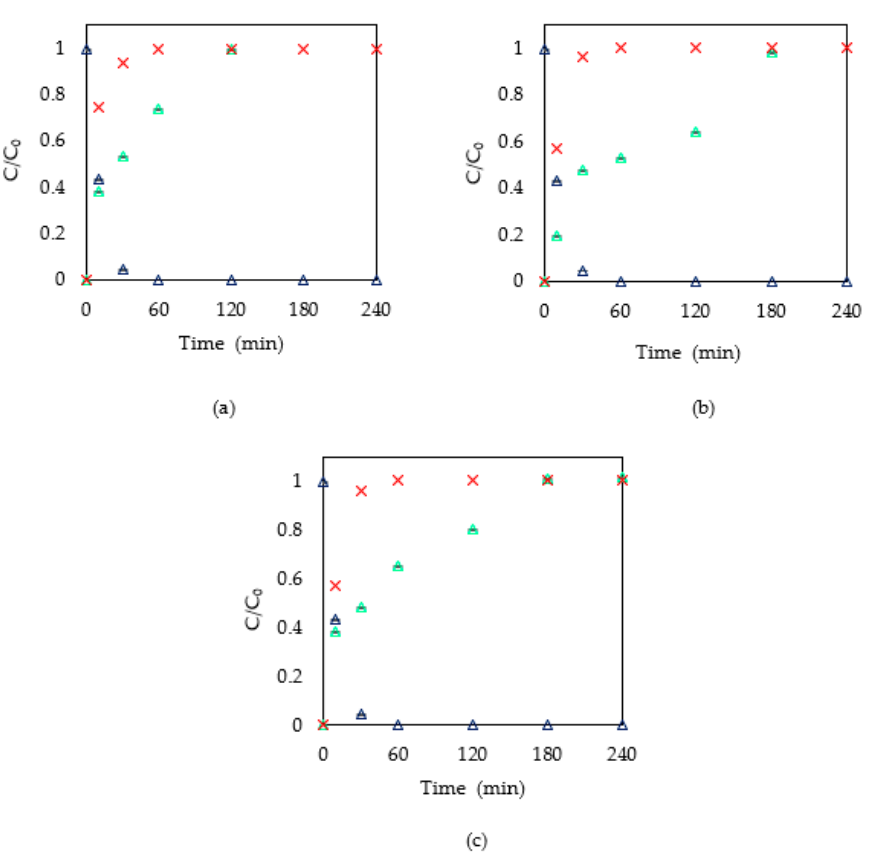
Figure 4. Chloride ions in solution ( a ) 0.5 g/L of TiO 2 , ( b ) 0.6 g/L of TiO 2, ( c ) 1 g/L of TiO 2 . ∆ MTLC removal, ∆ chloride ions released during MTLC removal, X chloride concentration corresponding to the theoretical chloride release from the MTLC molecule.